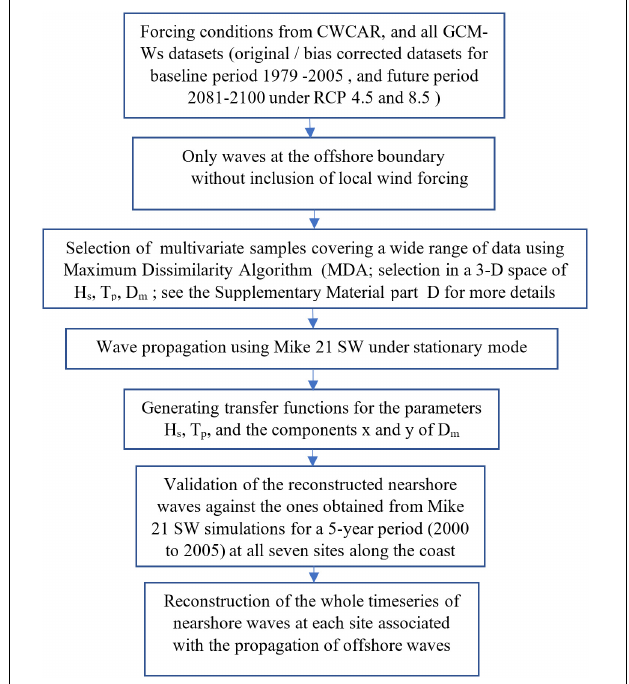
FIGURE 3 | Flow chart of nearshore wave